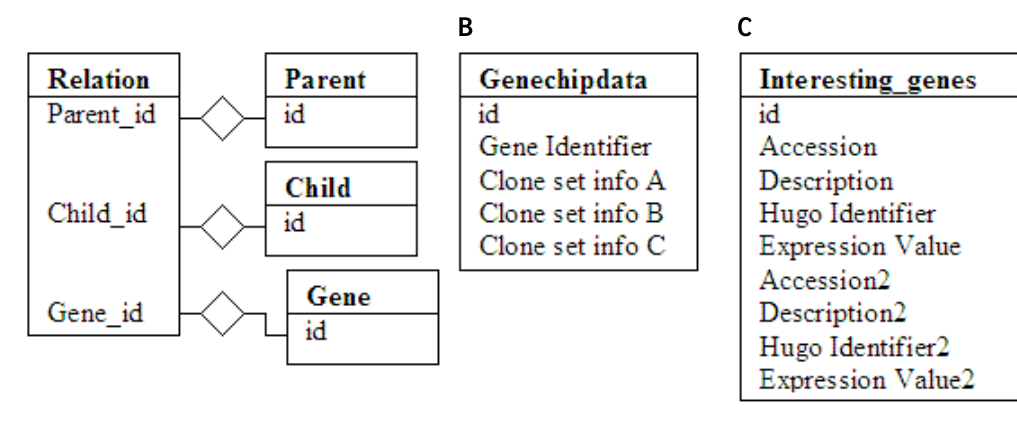
Figure 3: Database schemas for IGD, GCD and XD underlying CIDA (A) The ImmunoGenomicDatabase (IGD) consists of a parent, child and gene table, which are connected via their primary “id” keys to their respective foreign keys in the relation table. The tables are used to generate a multi-level hierarchy on the GUI. The relationship between the parent and child is one-to-many and many-to-many between child and gene. (B) The GeneChipDesign (GCD) database consists of a single table called Genechipdata to store the information from any given clone gene set. The field “id” is automatically populated when data is imported into the database. The second field must contain the gene identifiers within the clone set. Subsequent fields (maximum of 60) are for storing relevant information for each gene as decided by the user. (C) The ComparisonDatabase (XD) contains a table called interesting_genes allowing the user to import data multiple microarray experiments in the above sequence. The database is integrated with VisualBasic.Net and Microsoft Excel allowing manipulation of the stored data and extraction of biologically meaningful